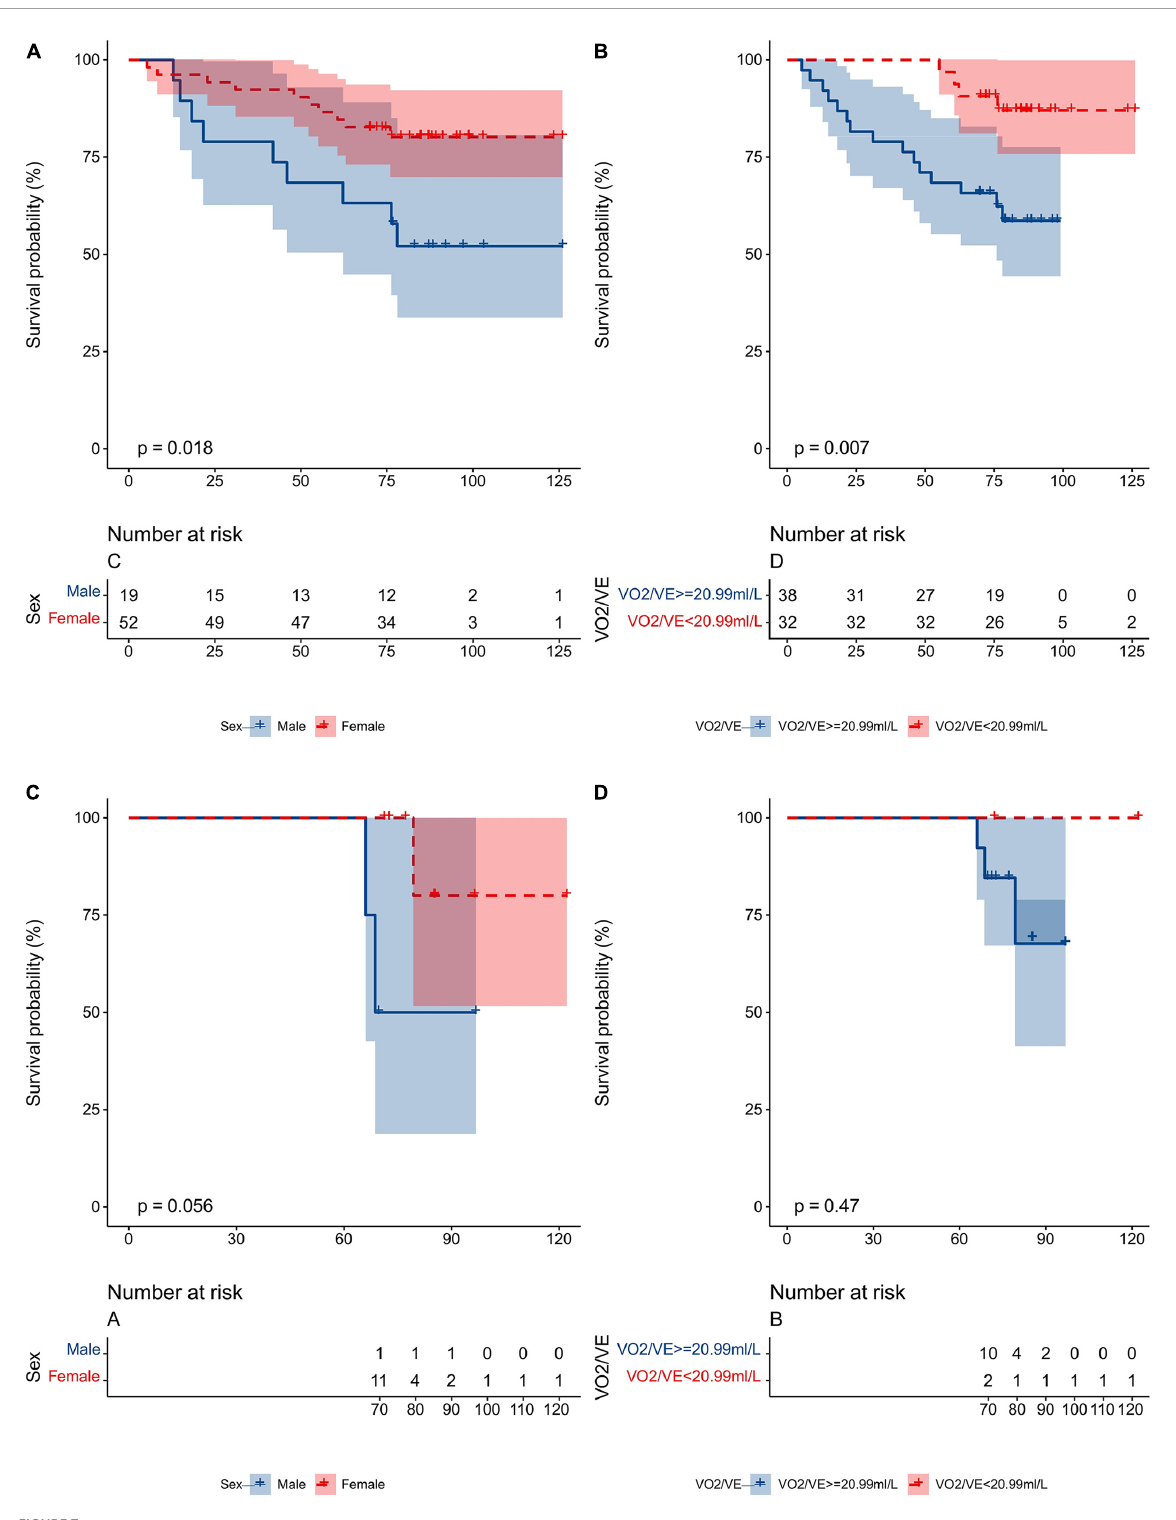
FIGURE7 Kaplan–Meier analysis for all-cause mortality in IPAH patients, separated by (A) sex in the EIS (–) subgroup; (B) VO 2 /VE ( < 20.99 ml/L vs. ≥ 20.99 ml/L) in the EIS (–) subgroup; (C) sex in the EIS ( + ) subgroup; (D) VO 2 /VE ( < 20.99 ml/L vs. ≥ 20.99 ml/L) in the EIS ( + ) subgroup. EIS, exercise-induced right-to-left shunt; VE, minute ventilation; VO 2 , oxygen uptake; IPAH, idiopathic pulmonary arterial